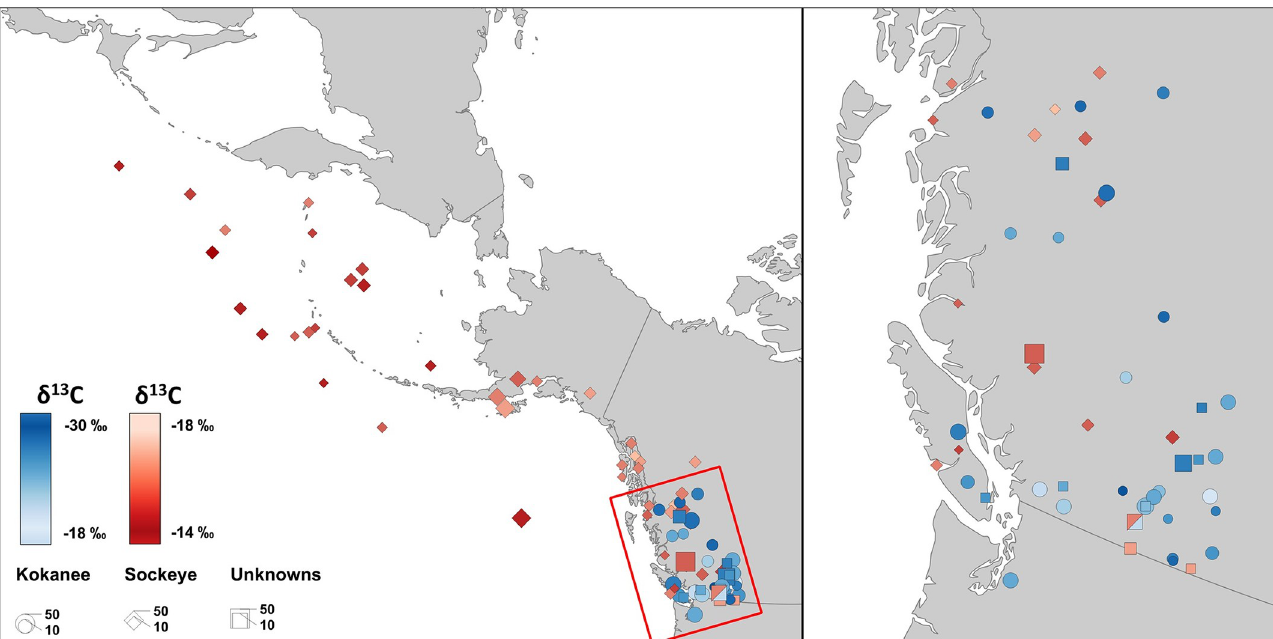
Fig 1. Map showing collection locations for samples. Known kokanee (circles) and sockeye (diamonds) as well as unknown (squares) samples are shaded in blue and red, respectively, according to the mean δ 13 C values.